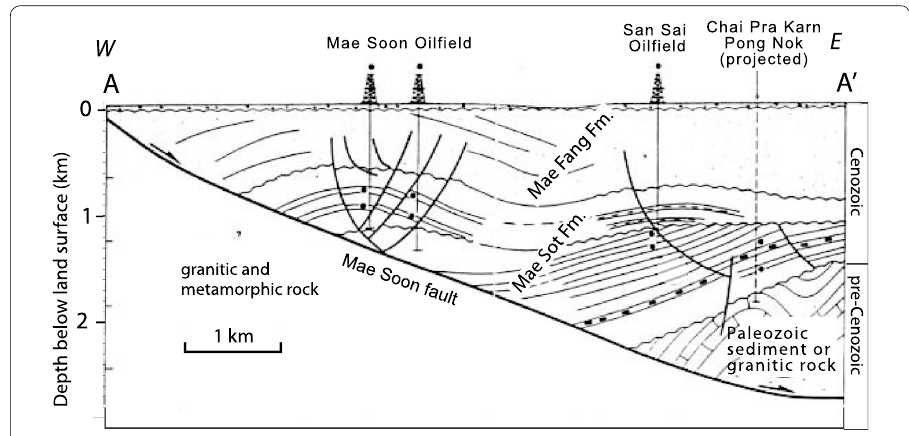
Fig. 5 Cross section of the southern Fang basin from Settakul (2009). Location of section shown on Figs. 2, 3. The section, based on proprietary seismic reflection profiles, shows the low-angle normal fault (“Mae Soon fault”) along the western boundary of the basin. Black dots indicate proven or potential petroleum traps